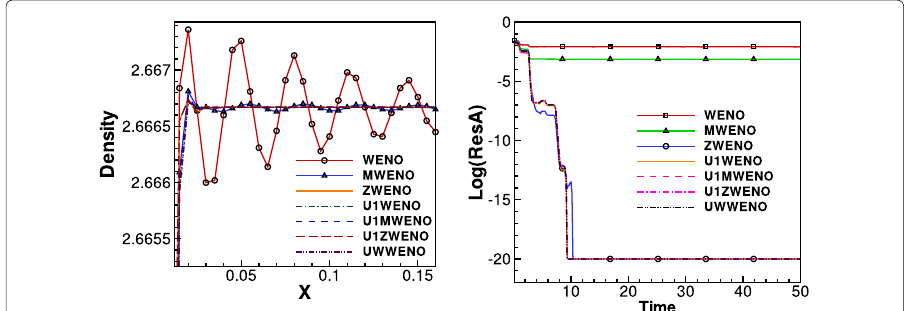
Fig. 7 Reproduced from [13]. Numerical solution of the 1D steady shock wave with Mach number M ∞ = 2 using the fifth-order WENO scheme with the upwind-biased interpolation. Left: zoomed density distribution downstream of the shock wave. Right: the time evolution of the average